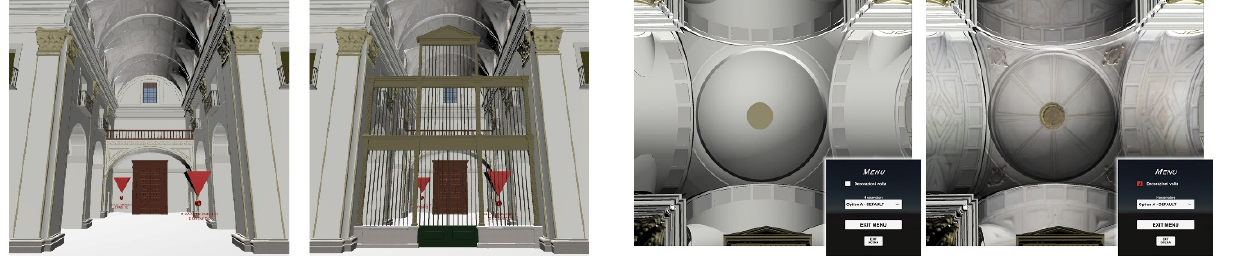
Figure 9: Activation of the on/off functions connected to the hotspot that allows you to manage the display of the gate. View of the nave from the transept.